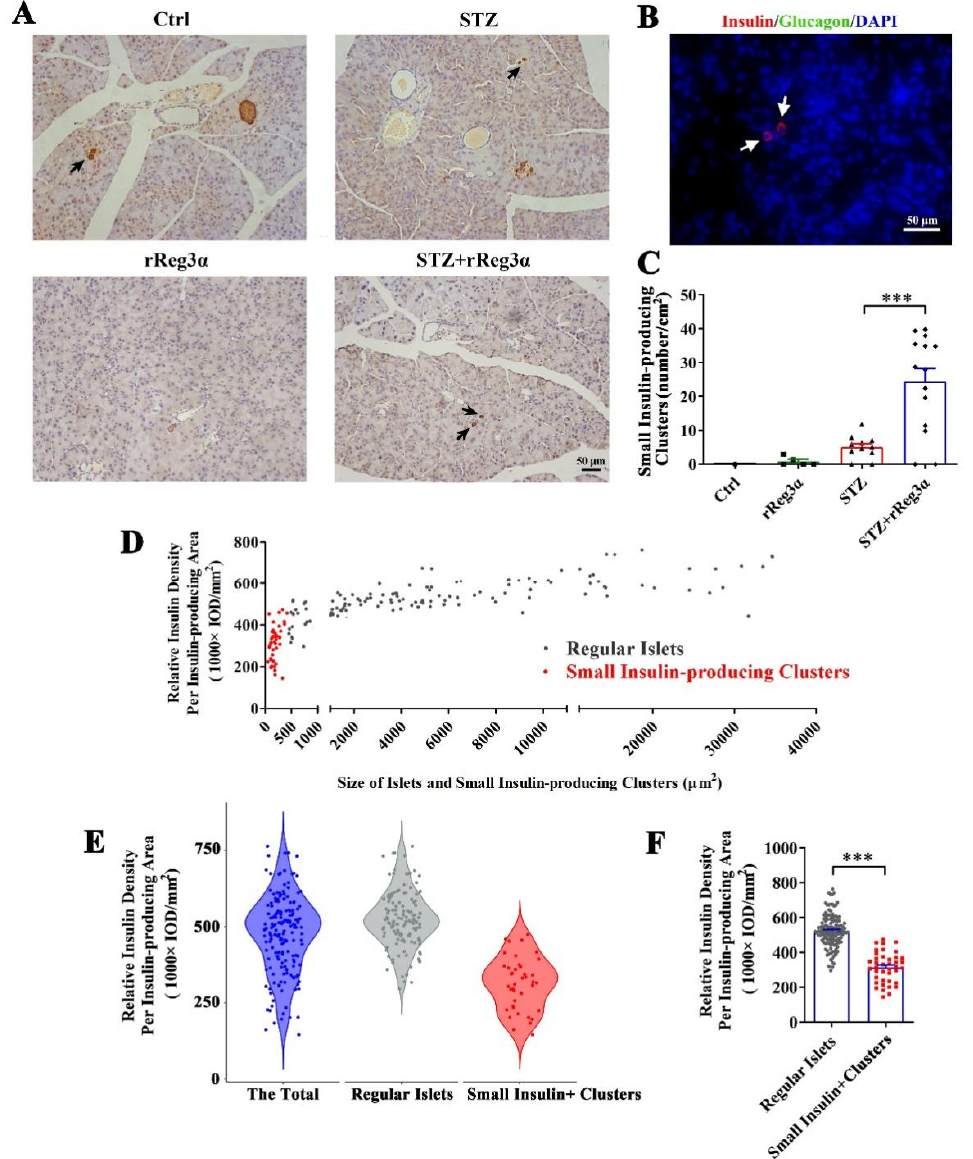
Figure 4. rReg3 α induces insulin-producing cell neogenesis in the exocrine pancreas. ( A ) Micrographs of immunohistochemical staining to insulin (200 × magnification) 15 d after STZ. A representative image is illustrated from each group. Up-left: the smallest islet, with a size of 425 µ m 2 , observed in the pancreas from the control group. Insulin-producing cell clusters with the size less than 425 µ m 2 were considered to be neogenic. Black arrows indicate the putative neogenic insulin-producing cells. ( B ) Immunofluorescent staining to insulin and glucagon (400 × magnification). A representative view is illustrated from all four groups. ( C ) Statistical analysis of the number of small insulin-producing clusters in panel A. *** p < 0.001 using one-way ANOVA, N = 5, 5, 11, 14. ( D ) Analysis of the regular islets (gray) and small insulin-producing clusters (red) in size and insulin density in the pancreas from STZ+rReg3 α mice. ( E ) Violin plot of panel D. ( F ) Statistical analysis in panel E. *** p < 0.001 using one-way ANOVA. Regular Islets: insulin-stained structures with a size larger than 425 μ m 2 , N = 133. Small Insulin+ Clusters: insulin-stained structures with a size less than 425 μ m 2 , N = 42.